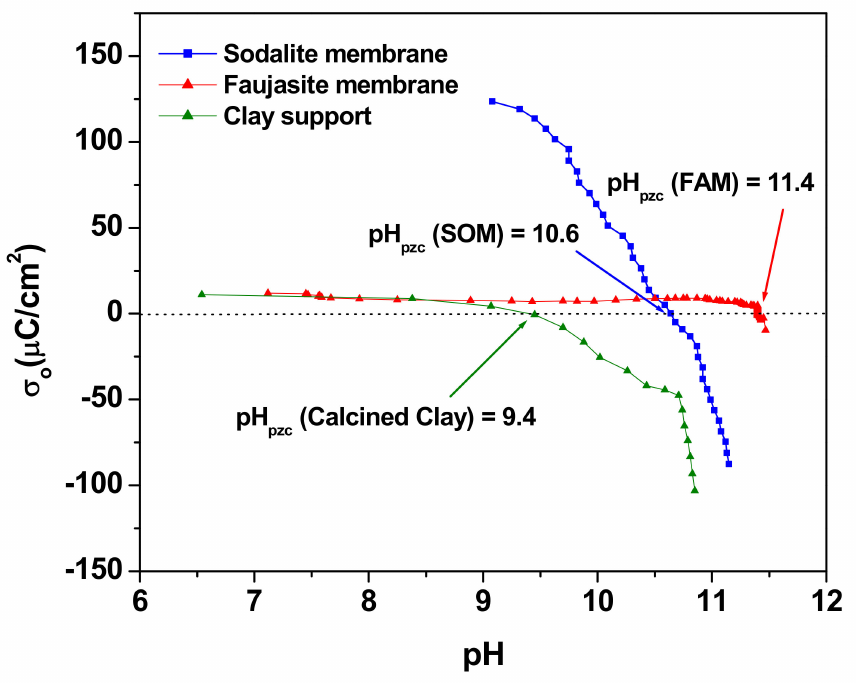
Figure 7. Charge density curves for clay support (olive), SOM composite membrane (blue), and FAM composite membrane